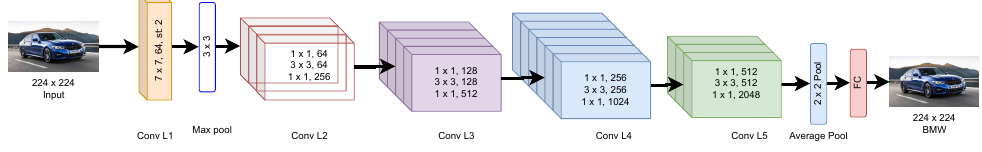
Figure 4. ResNet50 CNN network